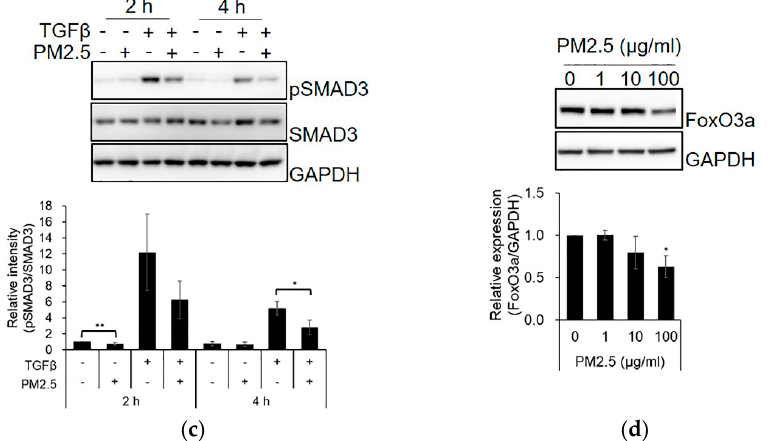
Figure 2. PM 2.5 affects SREBP-, MAPK-, TGF β -SMAD3-, and FoxO3a-related signaling. ( a ) SZ95 sebocytes were treated with PM 2.5 (100 μ g/mL) for 48 h. The cells were lysed with hypotonic buffer, and the cytosolic fraction and nuclei were separated. SZ95 sebocytes were treated with PM 2.5 or TGF β for the indicated times ( b , c ) or 48 h ( d ). The expression levels were analyzed by SDS-PAGE and immunoblotting for the indicated antibodies. The relative intensity of proteins was quantified using the Image J program. Data were analyzed by Student’s t -test (* p < 0.05, ** p < 0.01 vs. untreated control; n = 3).